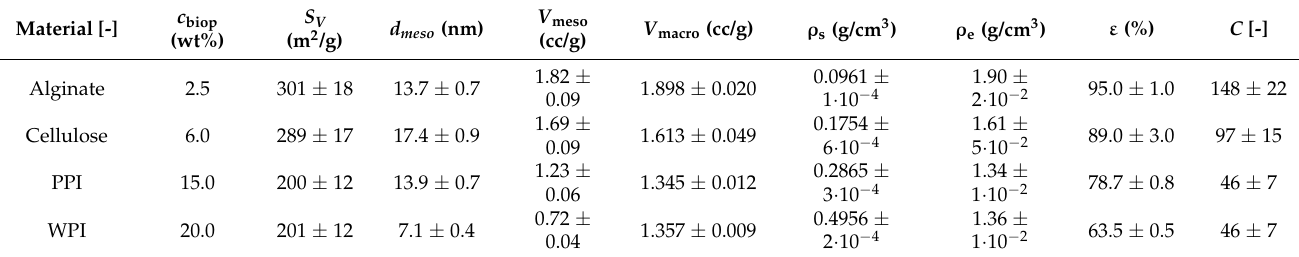
Table 3. Properties of non-treated aerogels produced from different